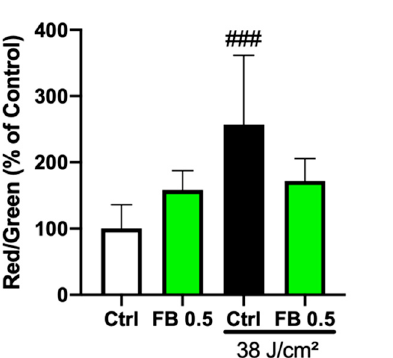
Figure 3. Mitochondrial membrane potential and morphology in HDF exposed to blue light and FB pre-treatment. Changes were evaluated using the mitochondrial potential indicator JC-1 (5,5,6,6 (cid:48) -tetrachloro-1,1 (cid:48) ,3,3 (cid:48) -tetraethylbenzimi-dazoylcarbocyanine iodide). Morphology was evaluated using MitoTracker ® . Non-irradiated and blue light irradiated HDF ( a ). Quantification of JC-1 red/green fluorescence ratio by using ImageJ ( b ). Data are shown as mean ± SEM. ### p < 0.001 vs. control. Scale bar 20 µm.